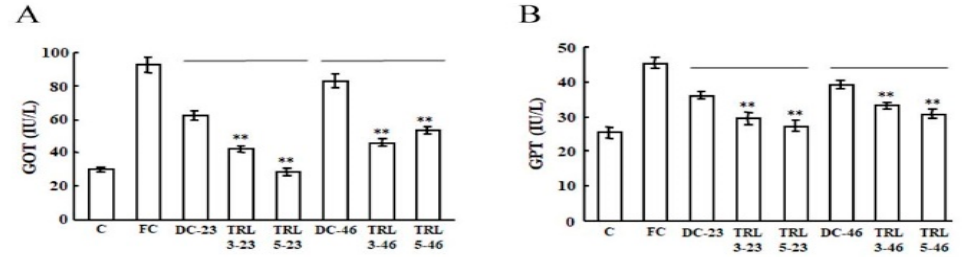
Figure 6. Effects of the transgenic rice on the liver function of mice. The levels of glutamic oxaloacetic transaminase (GOT; A ) and glutamic pyruvic transaminase (GPT; B ) in the mouse sera after four weeks of the oral administration of the various experimental diets. The statistical significance was set to ** p < 0.01.